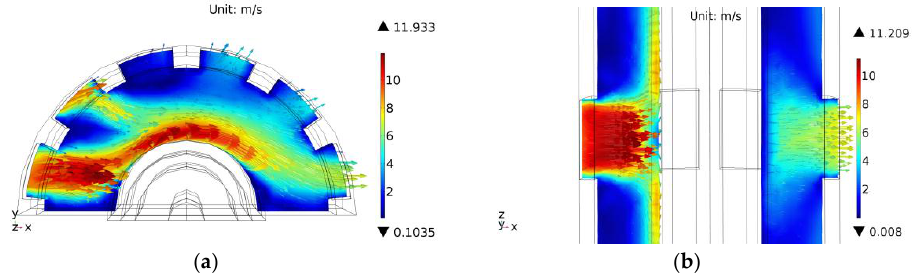
Figure 9. Inside air velocity profiles at an external wind speed of 10 m/s: ( a ) velocity profile in a horizontal cross section at z = 1000 mm; and, ( b ) velocity profile in a vertical cross section at y = 25 mm.